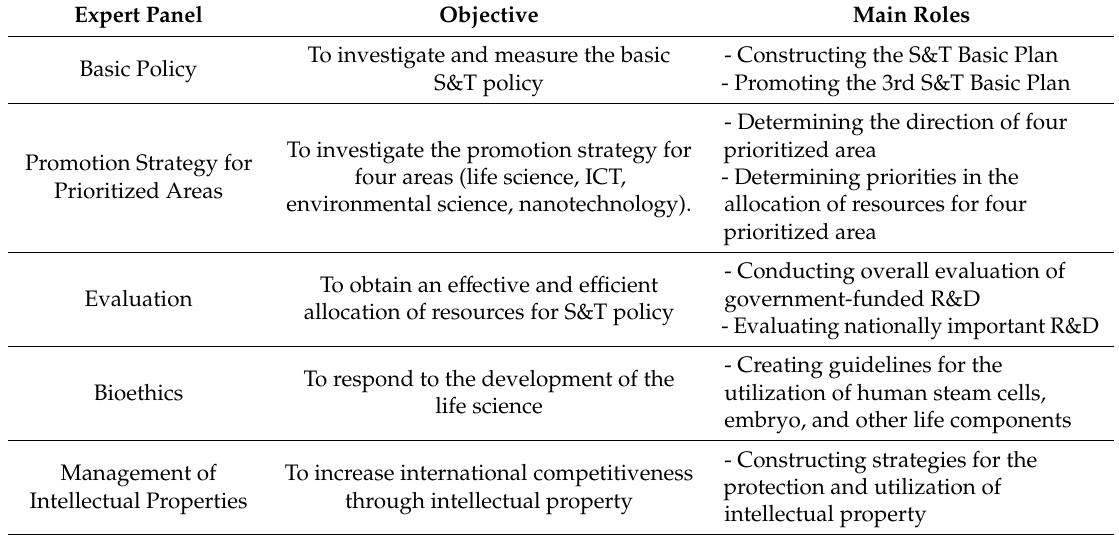
Table 3. Five expert panels of Council for Science and Technology Policy